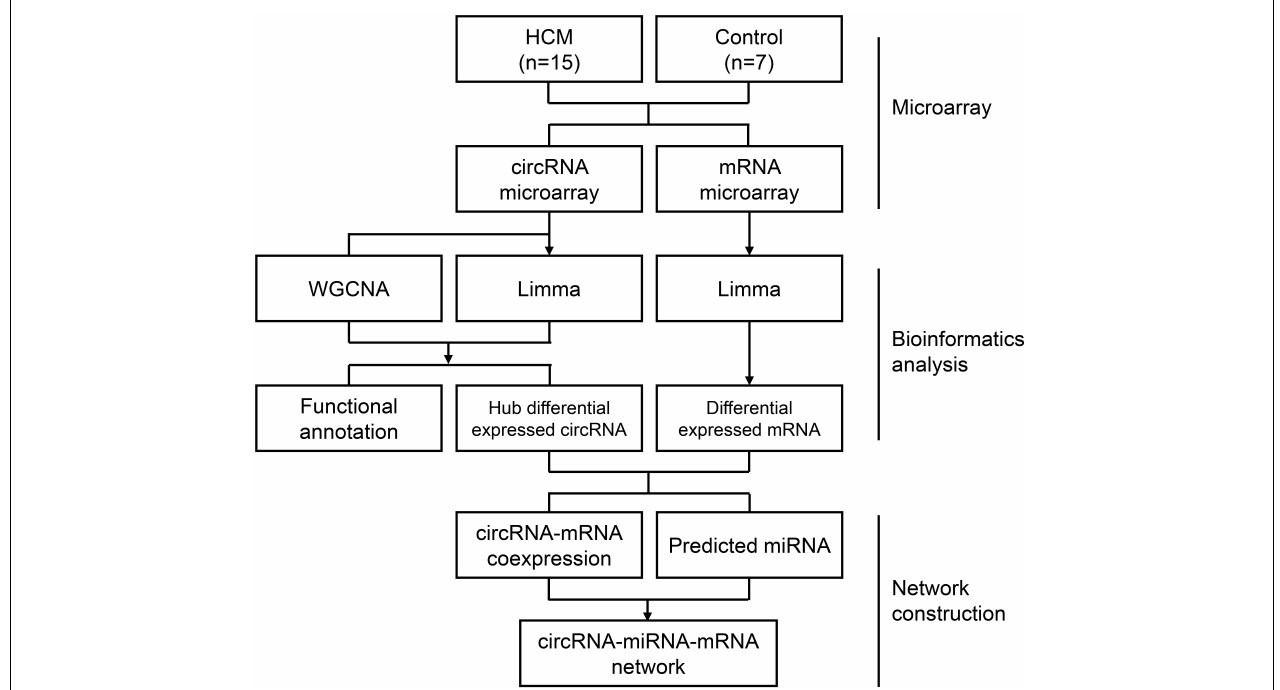
FIGURE 1 | Flow chart of the approach utilized in the present study. The WGCNA R package was used to construct a weighted correlation network. Differentially expressed RNAs was identified by Limma package in R. Correlation coefficients, miRWalk database, and Starbase database were enrolled for ceRNA network construction. HCM, hypertrophic cardiomyopathy; circRNA, circular RNA; miRNA, microRNA; mRNA, messenger RNA; WGCNA, weighted gene coexpression network analysis; Limma, linear models for microarray data.